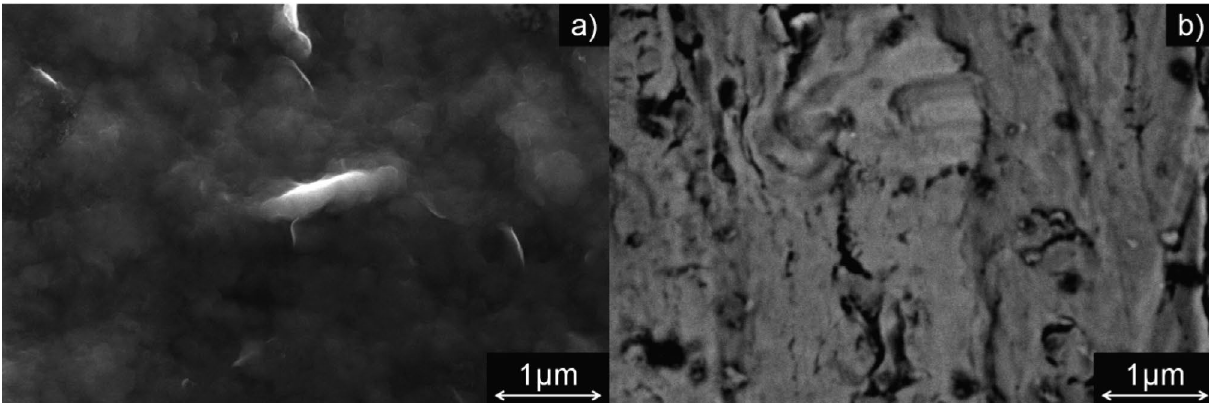
Fig. 1 SEM micrographies for Zr samples anodized at 5 V in a) E1; b)